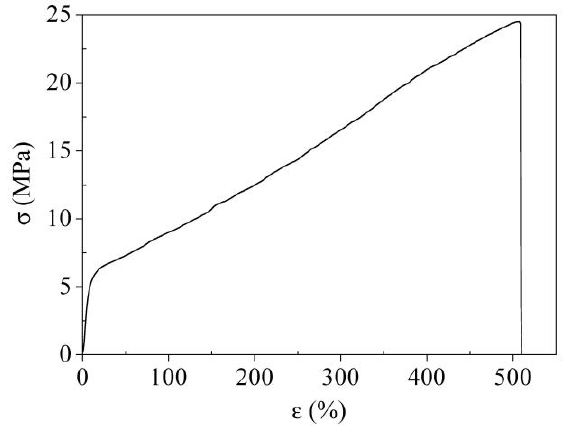
Figure 5. Representative stress-strain curve.